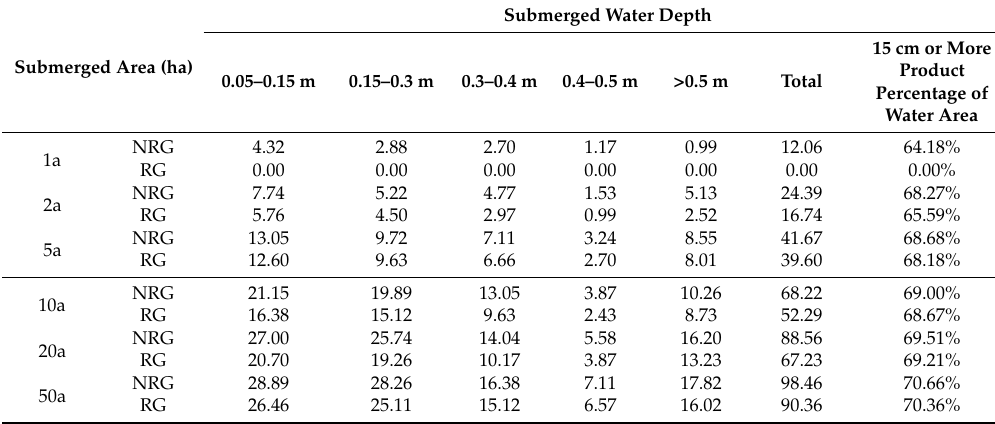
Table 5. Submerged range at different water